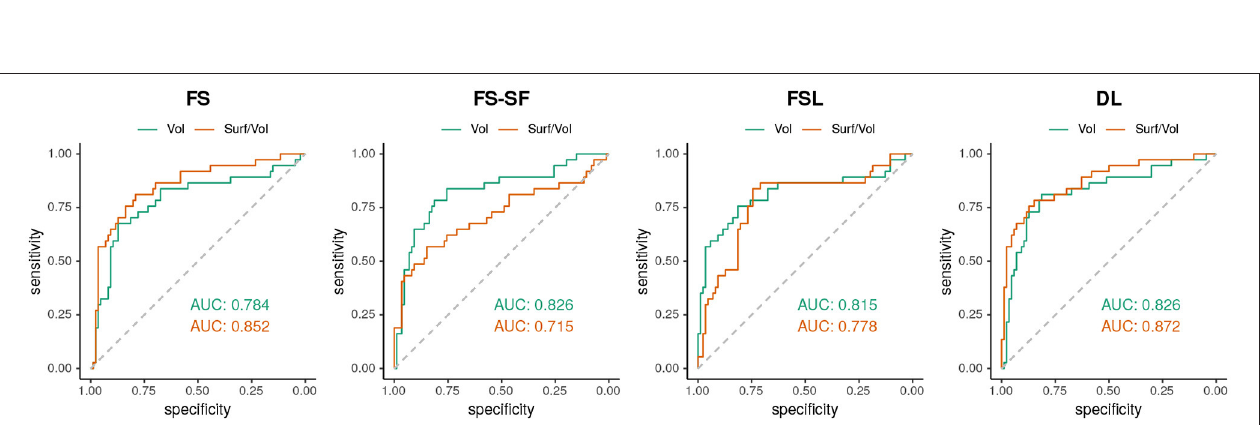
FIGURE 6 | ROC-curves using the absolute asymmetry index (AI) to separate between HS and all-other-epilepsies.